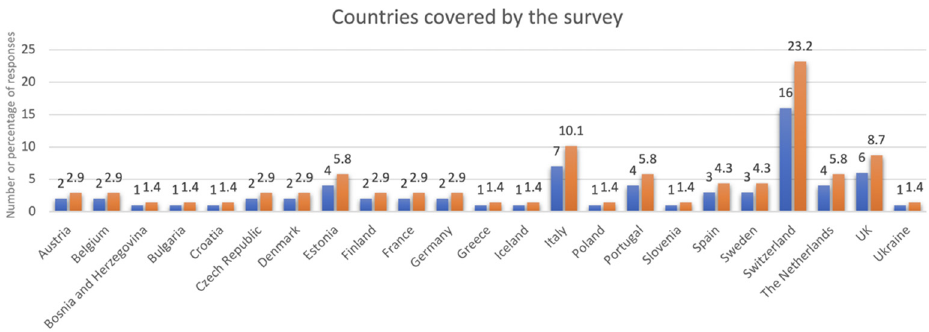
Figure 1. List of countries covered by the